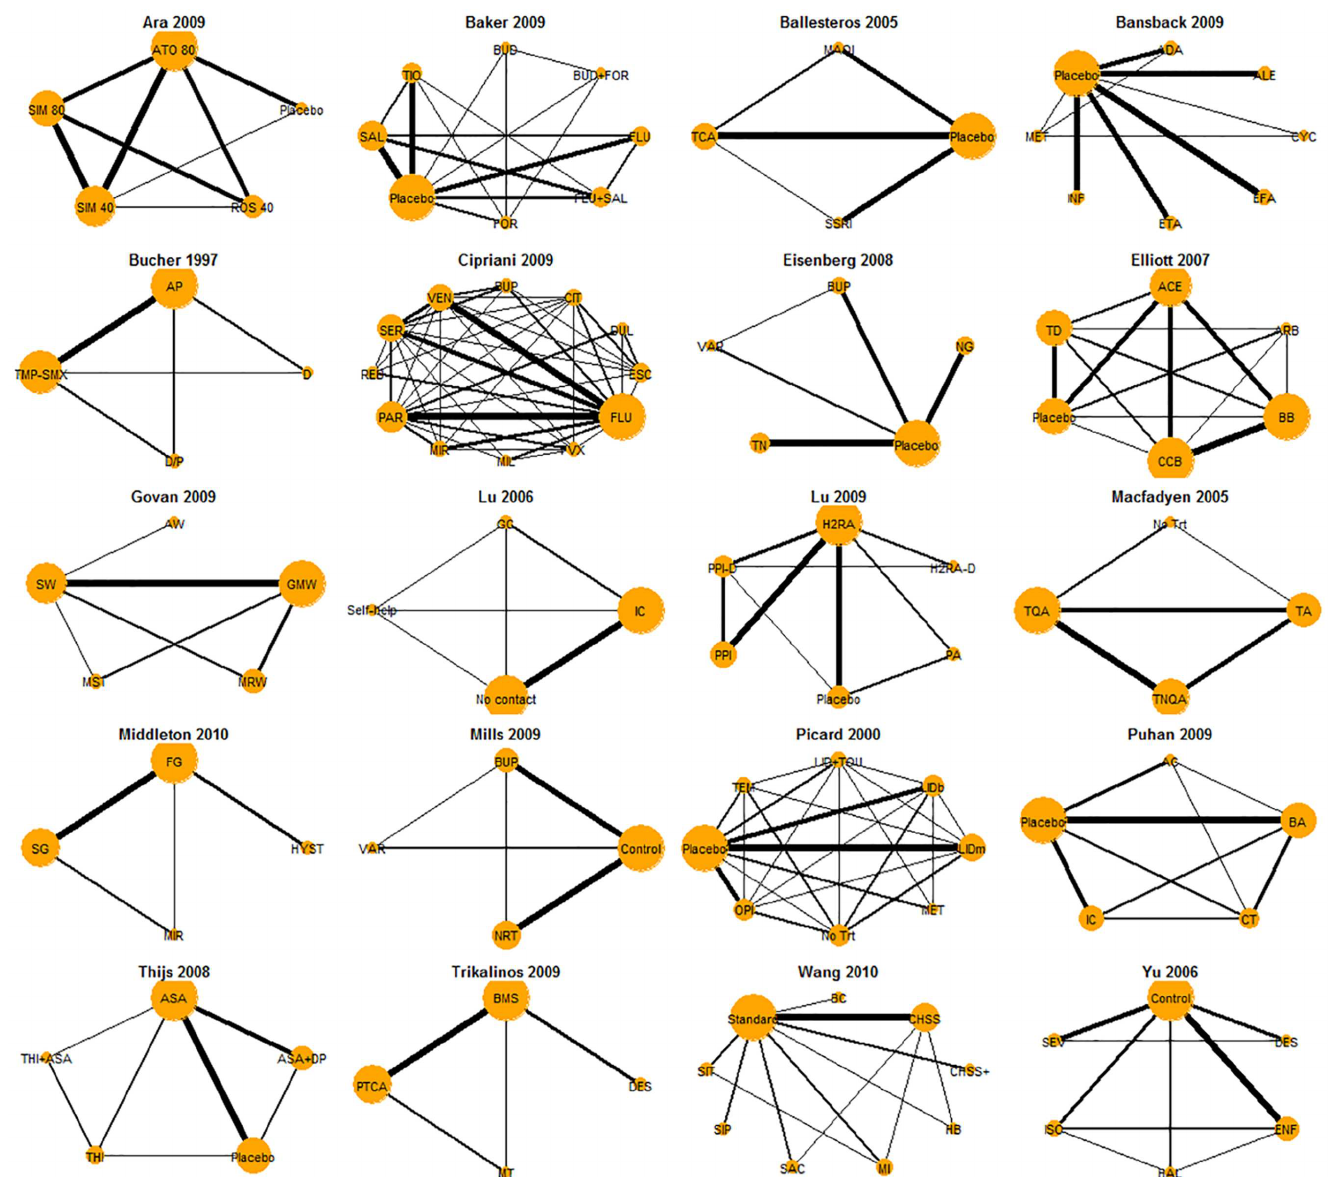
Fig 1. Graphacial representations for the 20 NMAs. The thickness of each link is proportional to the number of trials investigaing the relation, and the size of each treatment node is proprotional to the numberof direct comparisons that containthat